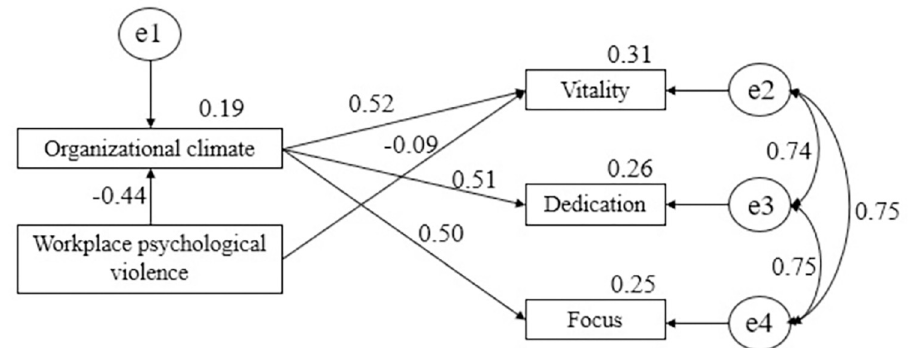
Fig 1. Organizational climate mediation models of the relationship between psychological violence and dimensions of work engagement (standardized).